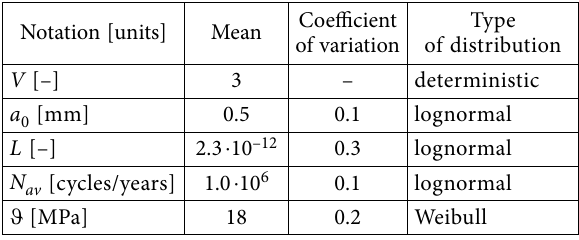
Table 2. Variables for Equation